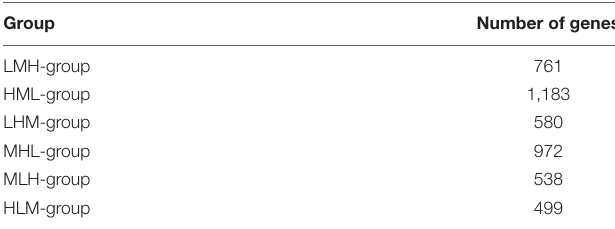
TABLE 2 | The number of genes for six expression